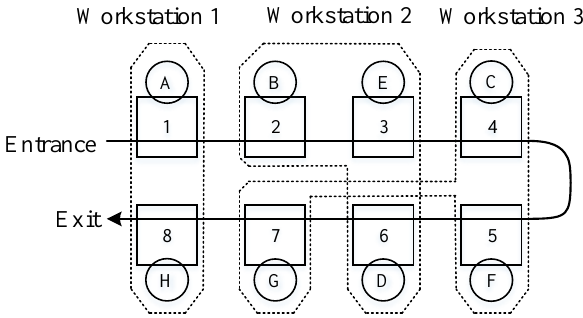
Figure 4. An example of interruption between operators.